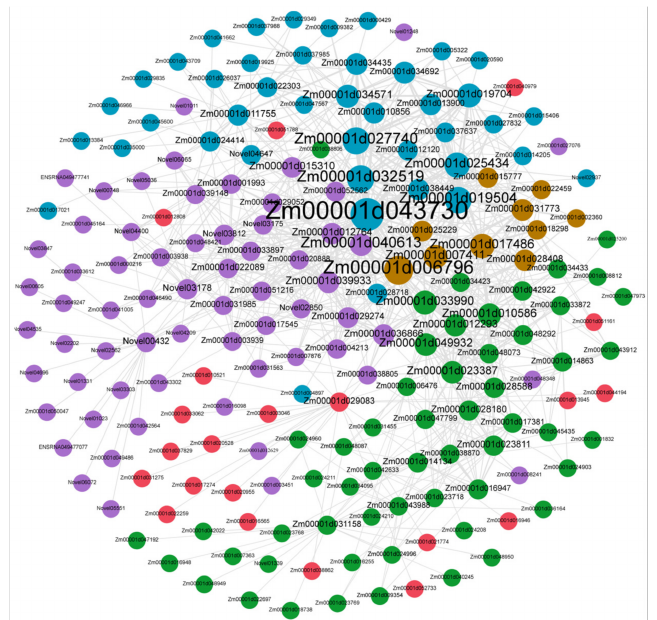
Figure 8. Analysis of candidate hub genes network interaction in the phenotypic significant en- richment module. The correlation network visualization of the interactions showed the connection between the top 20 genes with the highest connectivity in 71 candidate hub